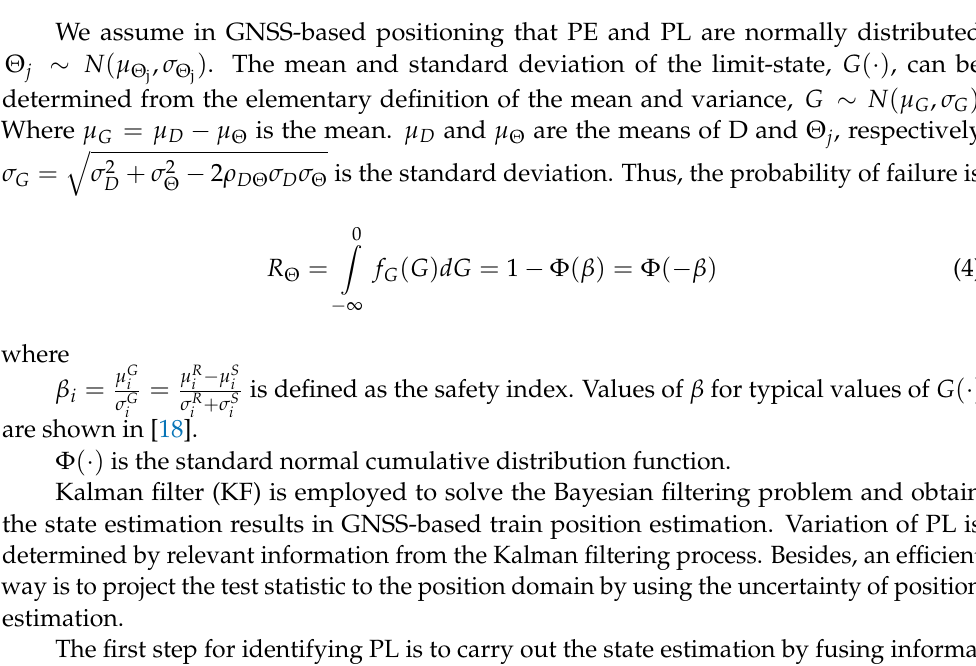
Figure 5. The distributed structure of the train integrity detection.